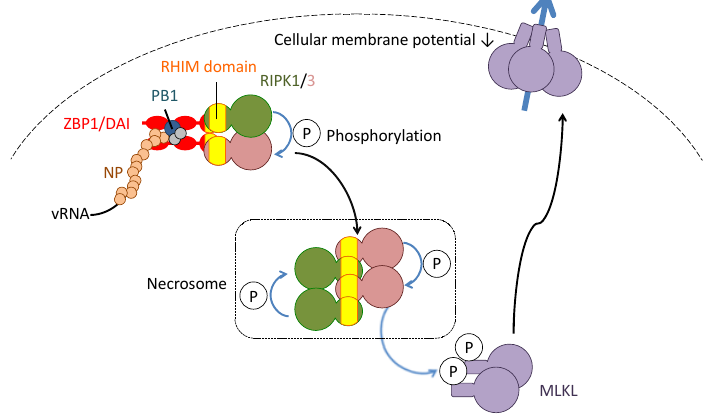
Figure 3. Molecularly-defined necroptosis induction in influenza virus infection. The complex of vRNA and nucleoprotein (NP) and polymerase basic protein 1 (PB1) of the influenza virus is recognized by the Z-DNA-binding protein 1/DNA-dependent activator of IFN-regulatory factors (ZBP1/DAI). The ZBP1/DAI induces oligomerization of receptor-interacting kinase (RIPK)1/3. Within the oligomeric kinase complex (namely, the necrosome), each RIPK phosphorylates and activates together. The activated RIPKs phosphorylate and activate mixed lineage kinase domain-like (MLKL). The phosphorylated MLKL translocates from the cytosol to the cellular membrane. The translocated MLKLs form a cellular channel to permeabilize the cellular membrane.